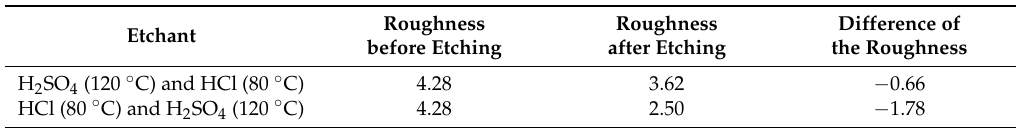
Roughness before Etching